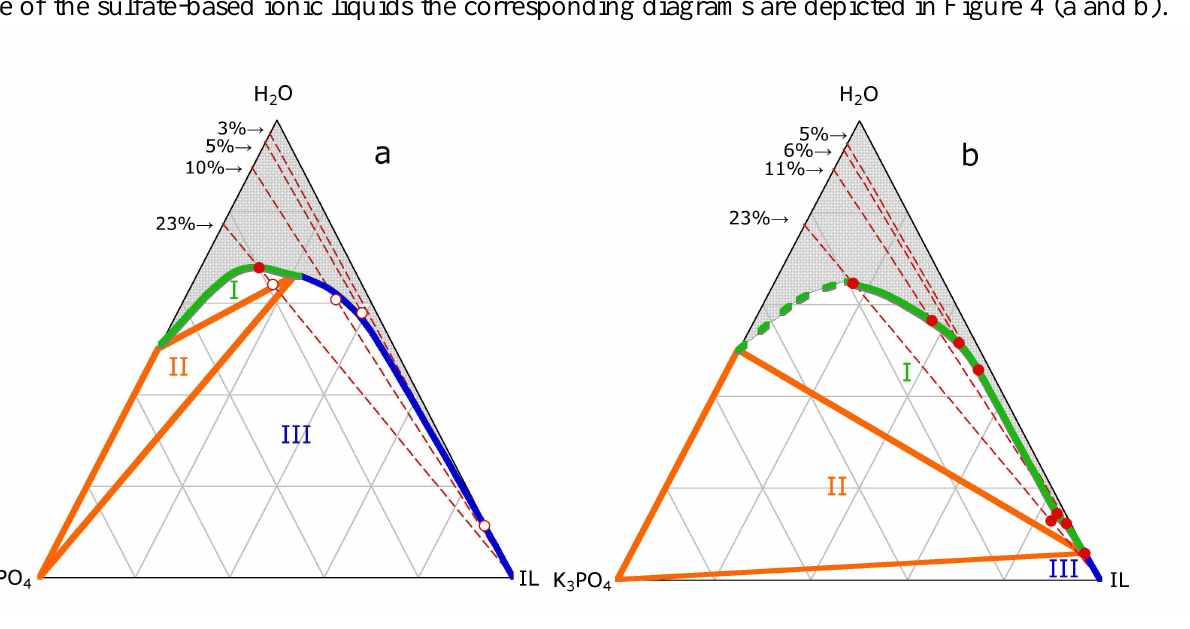
PO + [ C mim ][ Me OSO 3 4 4